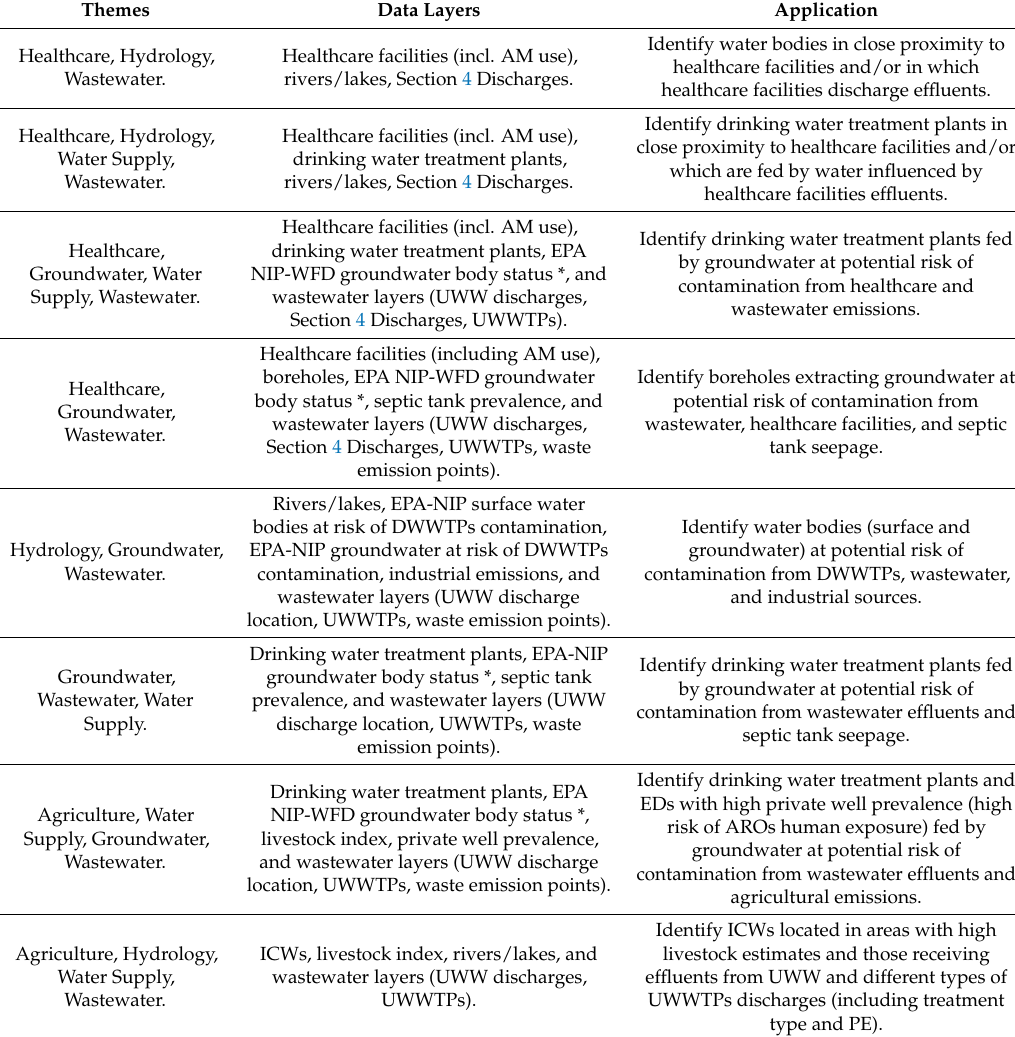
Table 3. Selected examples of thematic maps and data layer combinations generated in the mapping